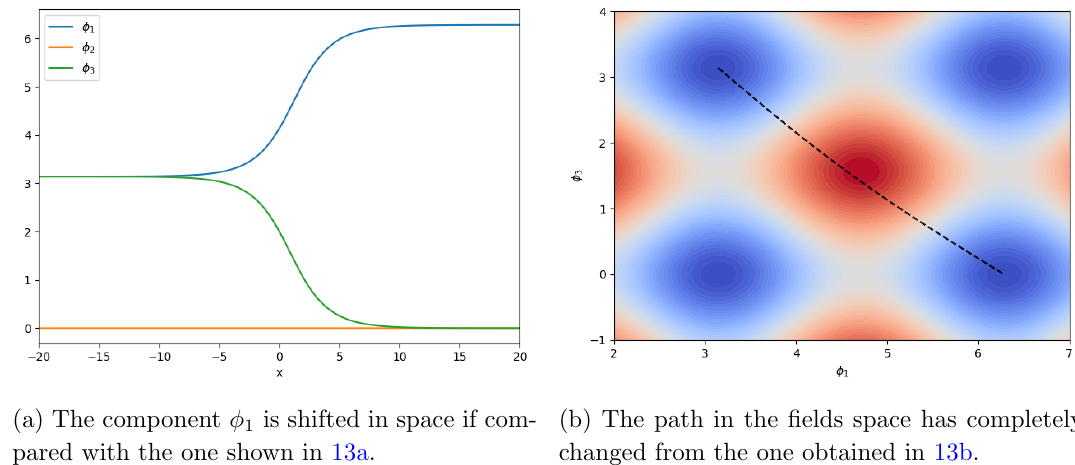
Figure 14. A BPS solution of the su (4) FKZ model for the particular case where (cid:30) 2 =